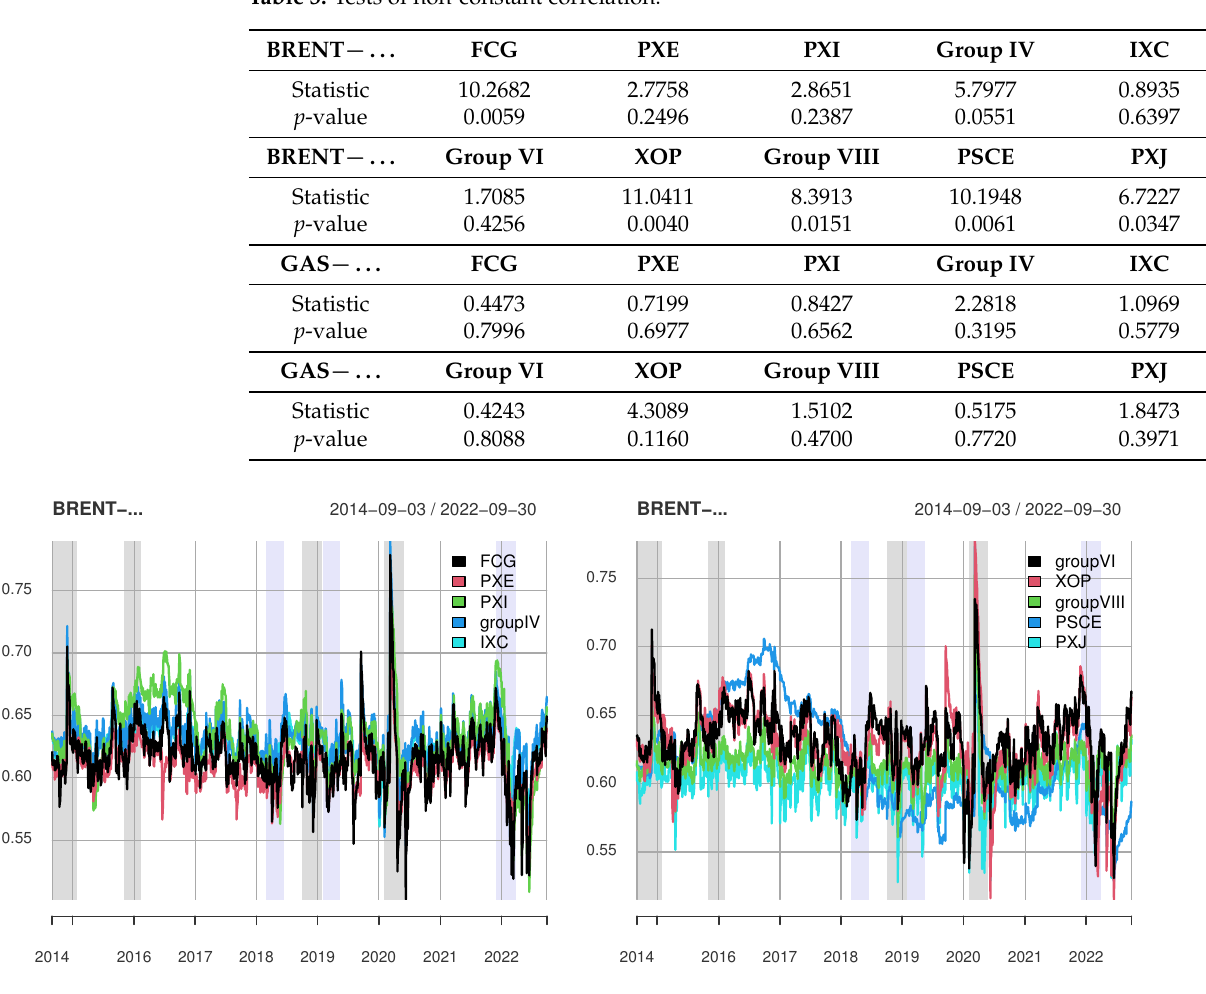
Figure 6. Conditional correlations between crude oil and ETFs.